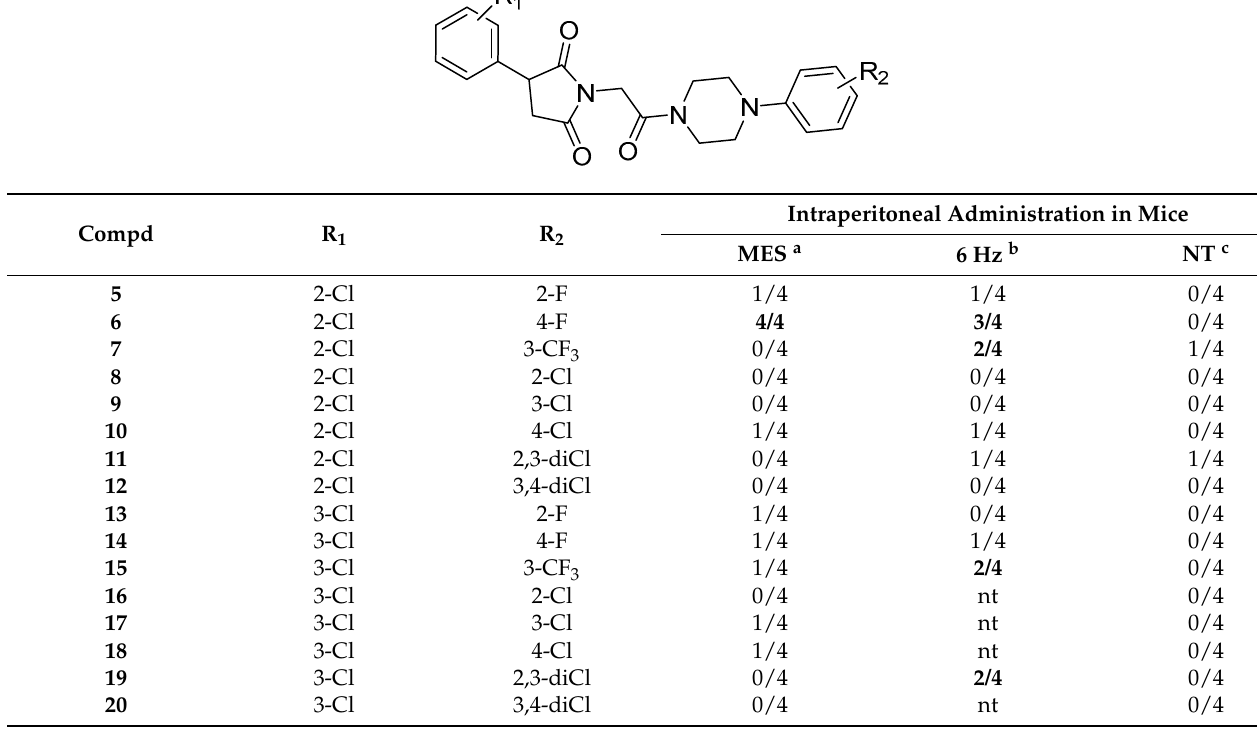
Table 2. Anticonvulsant activity (MES and 6 Hz tests) and acute neurotoxicity (rotarod test) following i.p. administration of dose 100 mg/kg in mice.